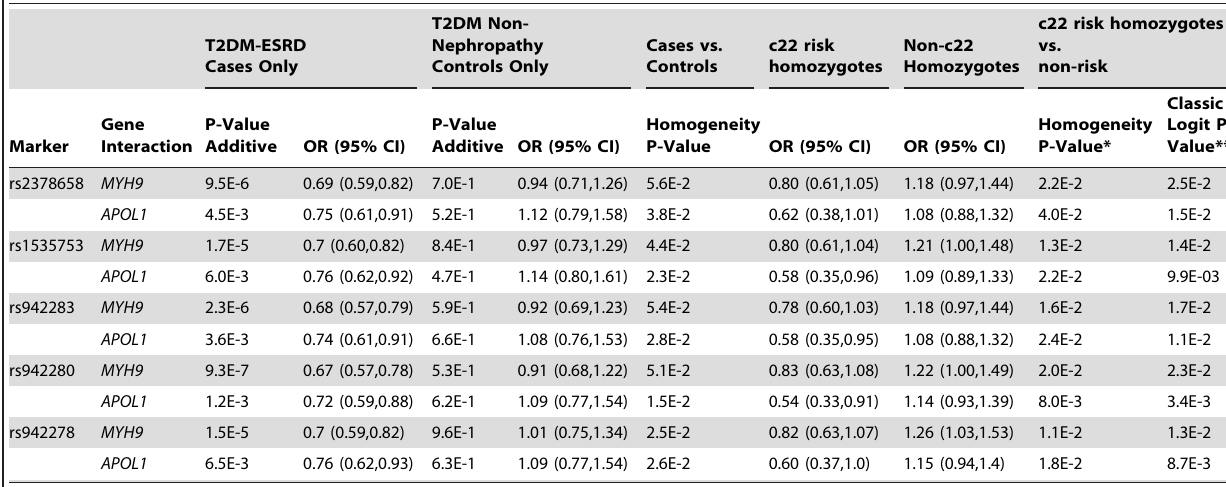
Table 5. Chromosome 22- FRMD3 interaction analysis.